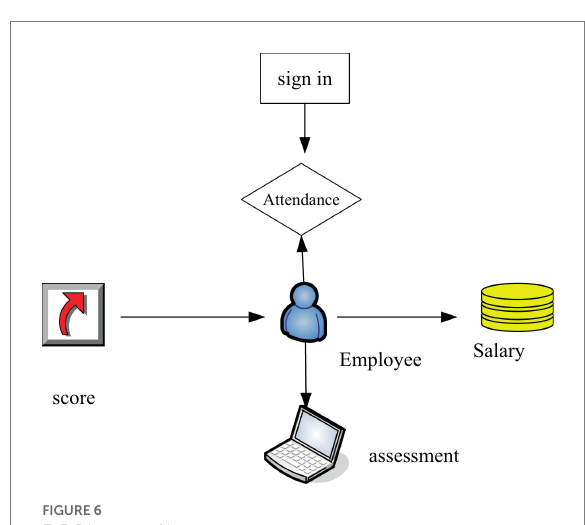
FIGURE 6 E-R Diagram of human resource management